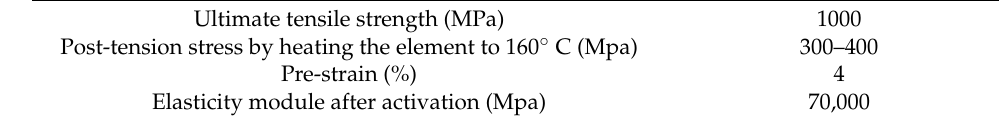
Table 2. Mechanical properties of iron-based memory alloy [49].